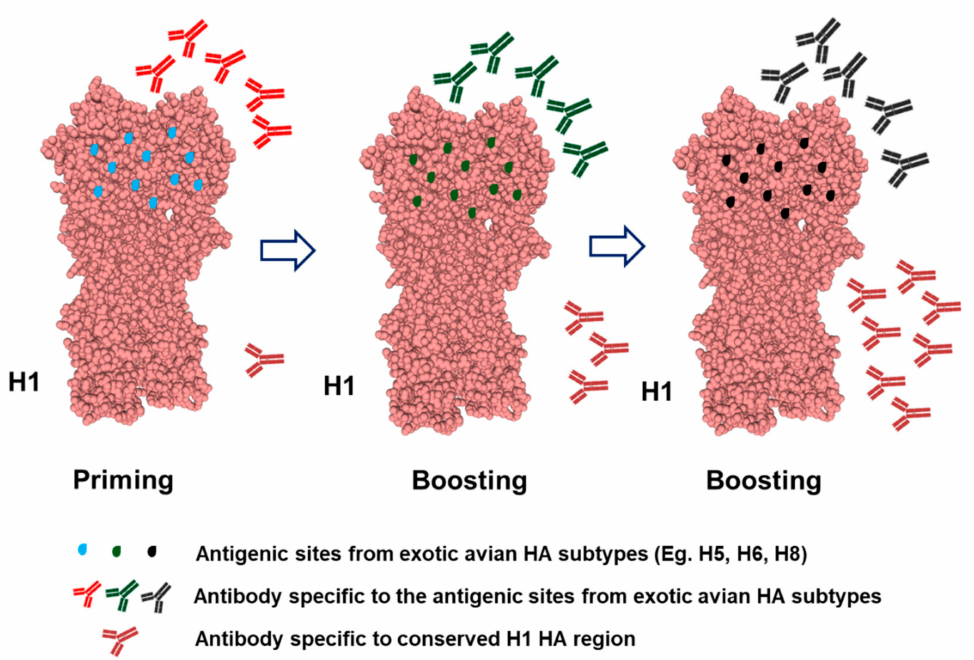
Figure 3. Mosaic HA vaccination approach. The mHA vaccine contains a head domain in which the variable immunodominant antigenic sites are replaced with antigenic sites from exotic avian HA subtypes while conserved regions of both head and stalk domain are retained (H1 HA in this example). Priming with mHA strongly induced an Ab response to the conserved antigenic sites, but only a weak Ab response to the conserved retained regions. However, boosting with the mHA head domain with antigenic sites from other exotic avian HA subtypes enhances Ab responses to both the head and stalk domains. The structure of HA was constructed using Swiss-Model (https: //www.swissmodel.expasy.org/, accessed on 5 April 2021). The representative virus is influenza A virus (A/California/07/2009(H1N1)) and the sequence was obtained from GenBank